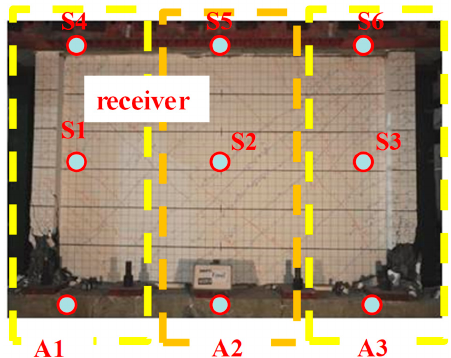
Figure 11. Regions and sensor locations for damage detection.